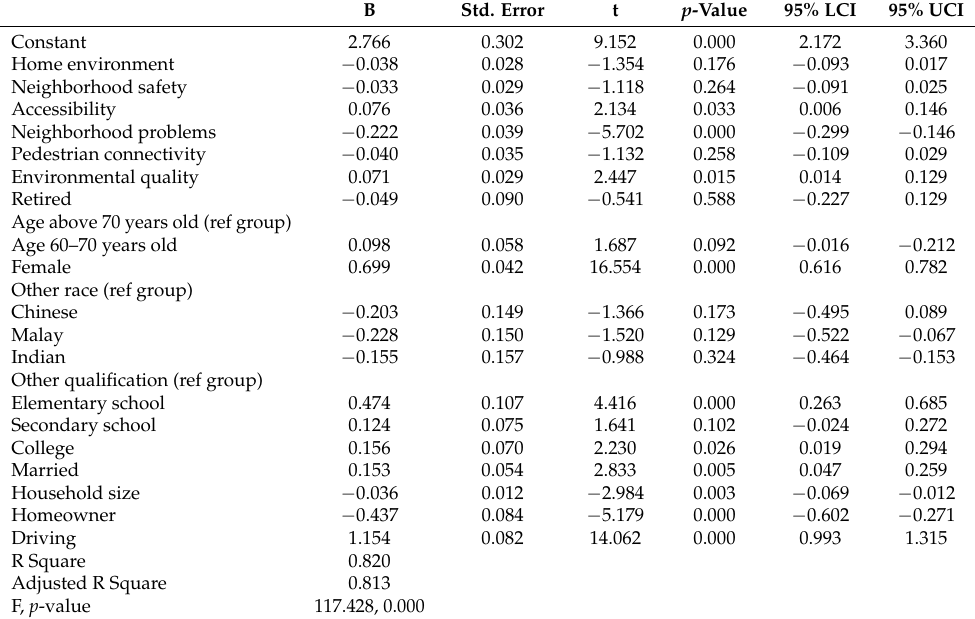
Table 3. Results of regression for mental